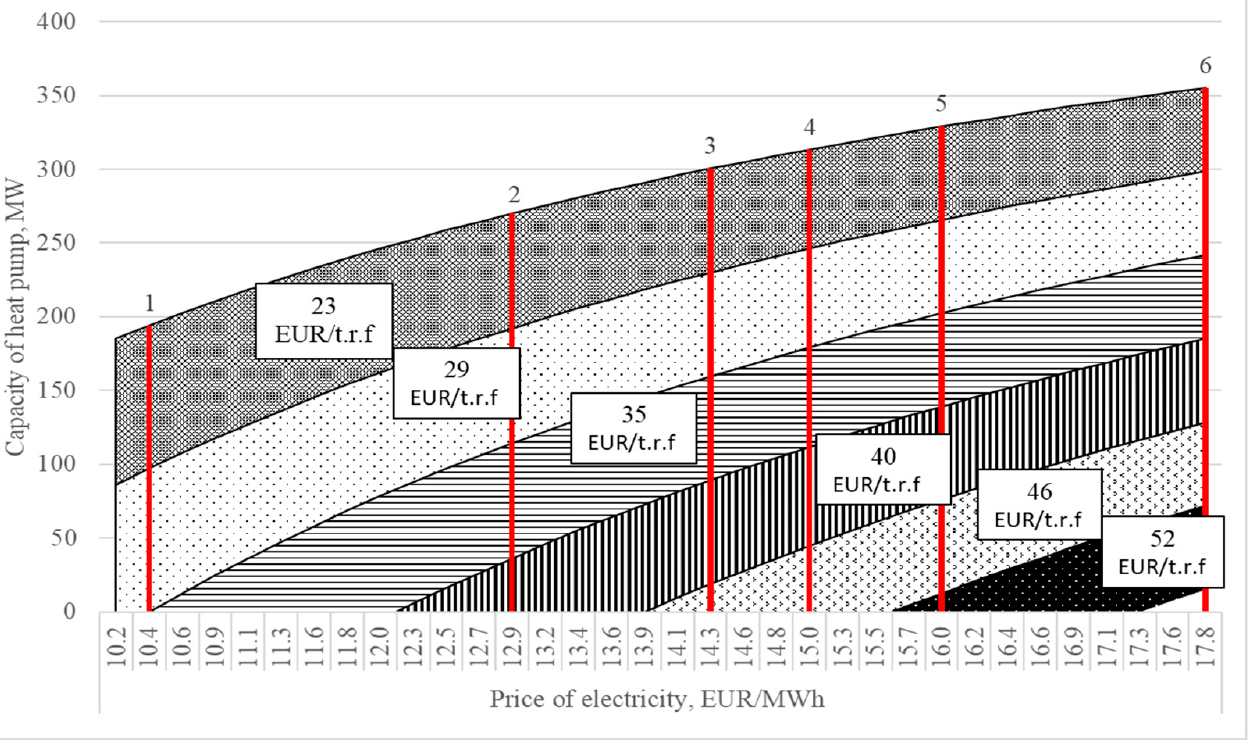
Figure 7. The range of permissible HP capacities: 1—CPS of Siberia; 2—CPS of the Urals; 3—CPS